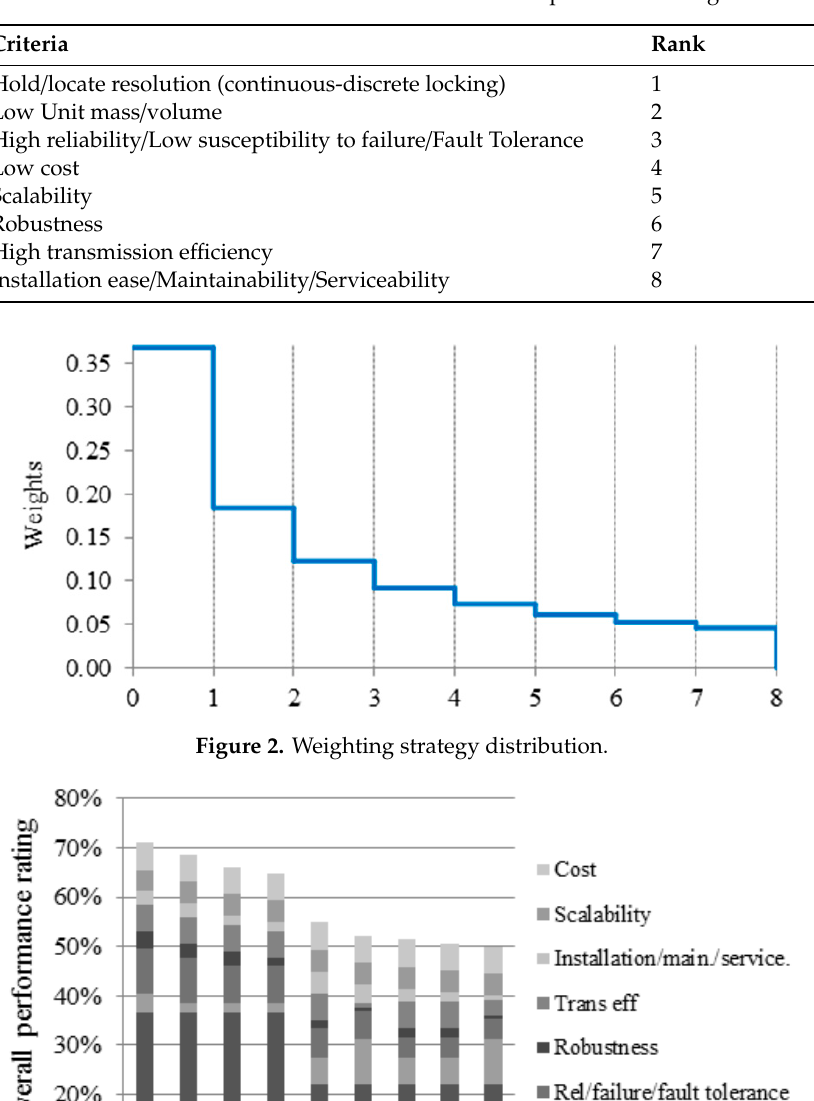
Figure 4. Winning concept (concept 1)—Worm gear driven threaded radial clamp with plain shaft frictional engagement. 3. Modelling and Simulation 3.1. Modelling Numerical analysis was used to develop a greater understanding of the concept prior to any product manufacture. Focusing resources at this early stage of product development minimised the risk in the final concept selection and helped reduce the need for multiple experimental testing platforms. A major factor was the required engagement force associated with the design, which engaged the radial arms that subsequently applied the required holding torque of 400 Nm. This engagement force is shown in Figure 5, labelled F . As a primary design intent was to minimise mass, establishing which solutions required the least amount of engagement force to achieve the holding torque whilst continually considering the design complexity of the solution was paramount. The numerical model helped establish key geometric parameters and acted as a guide to develop initial testing platform designs. Figure 5 demonstrates the forces experienced by one side of the clasp arrangement. In this case the engagement force is modelled as point load F (N), which subsequently results in a pressure between the shaft and the outer clasping arm.